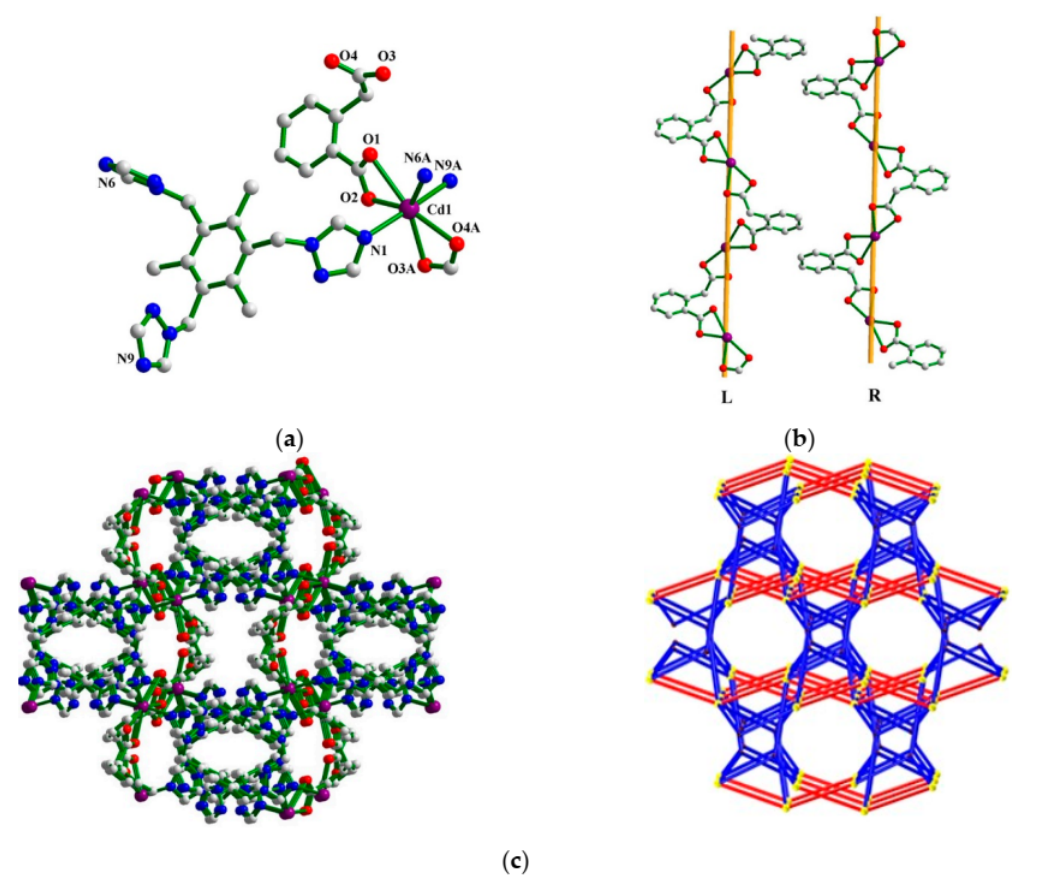
Figure 3. ( a ) Coordination environment of Cd(II) ions in 3 with hydrogen atoms omitted for clarity. ( b ) The Cd(II)/ o -cpla 2 − left- and right-handed helical chains along the b -axis. ( c ) Three-dimensional network and schematic representation of 3 . Blue line: tttmb; yellow node: Cd(II) ion; red line: o -cpla 2 −